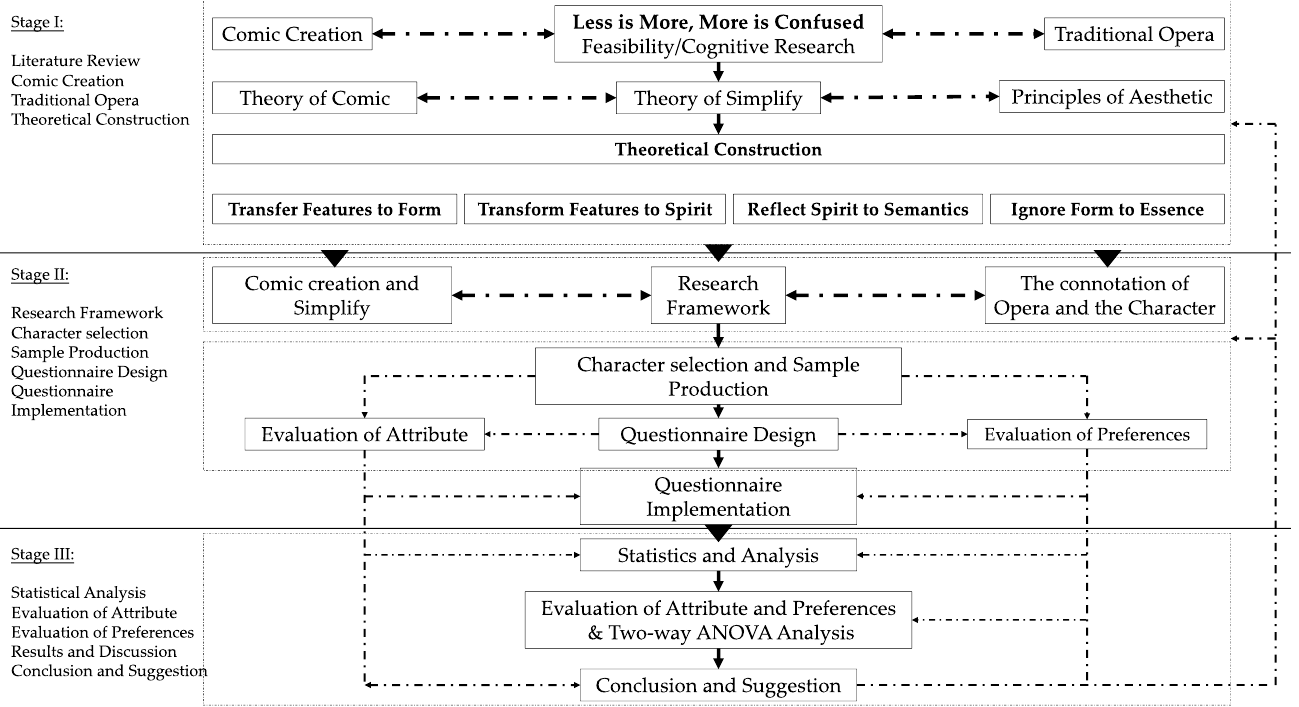
Figure 4. Three stages of research (Source: this study).